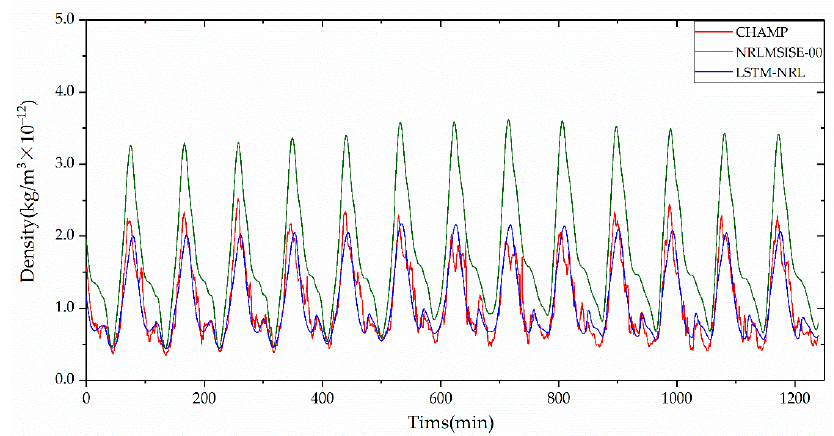
Figure 7. The three density series on day 231 of 2007, Test 4. It is clear that the densities from the LSTM-NRL (blue lines) are much closer to the “true” density (red lines) than those from the NRLMSISE-00 (green lines) on both days. Both in the general trends and at extremes, the densities from the LSTM-NRL are highly consistent with the “true” densities. The RMSE and R with respect to the empirical model and LSTM-NRL on the two days are presented in Table 5. The improvement on RMSE is 67.3% and 73.0% on day 30 and day 231, respectively. Table 5. The performance of the LSTM-NRL in Test 4. It is noted that the best results, in terms of RMSE and R , are bold in the table. Day